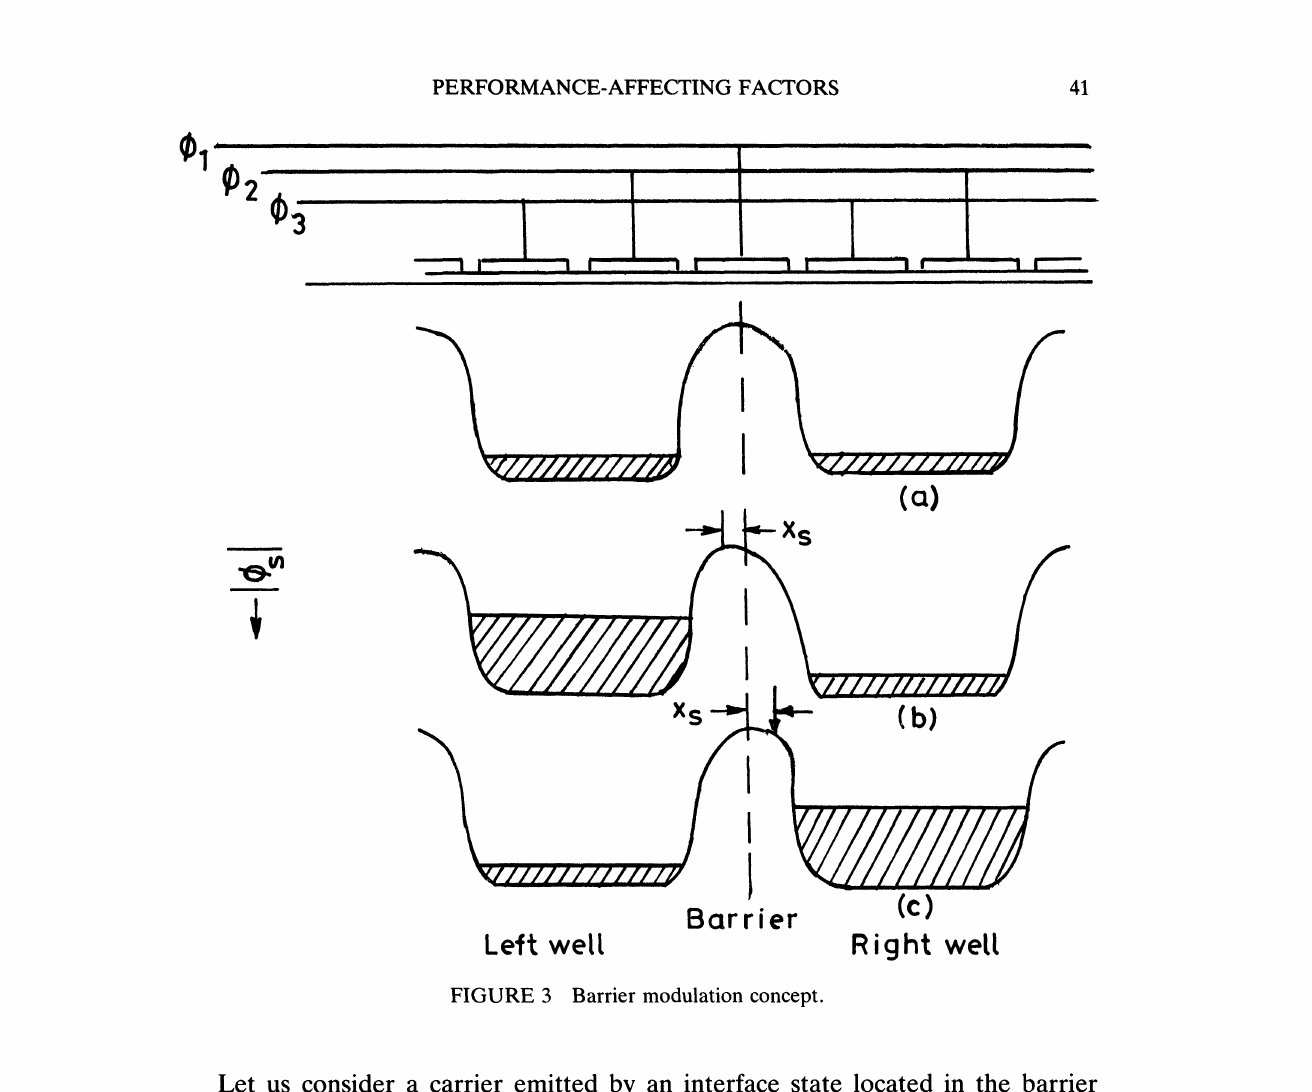
FIGURE 3 Barrier modulation